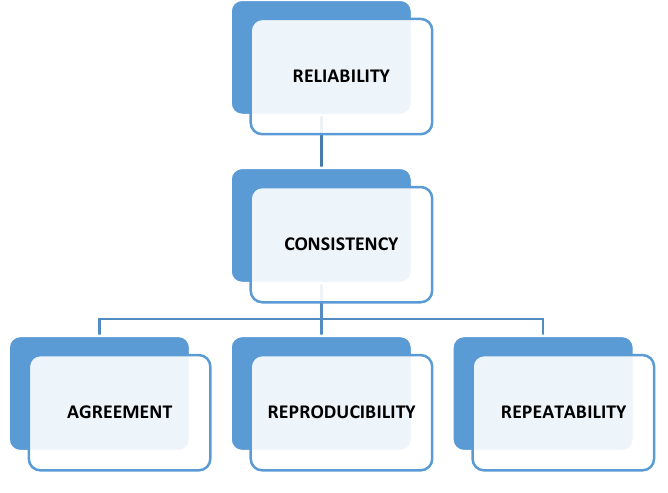
Fig. 1. Reliability and its